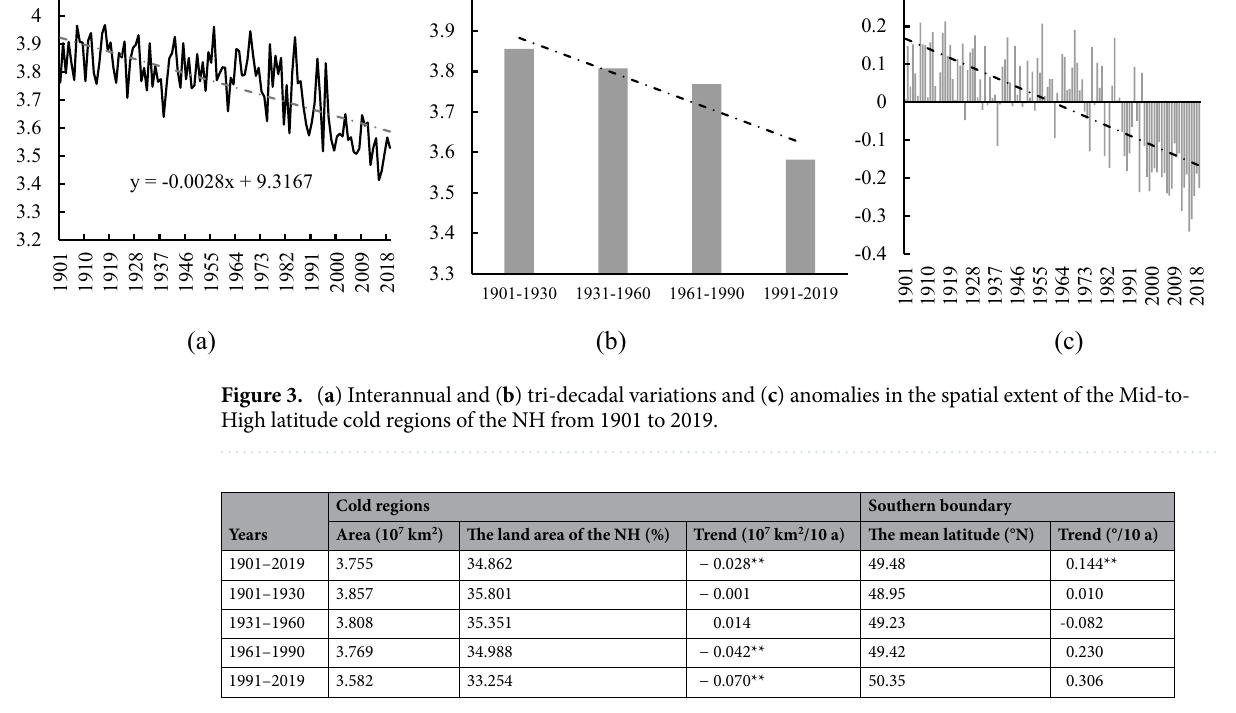
Table 2. Variations of the spatial extent and the southern boundary of the Mid-to-High latitude cold regions from 1901 to 2019. “*” and “**”: P < 0.01 and 0.001, respectively.